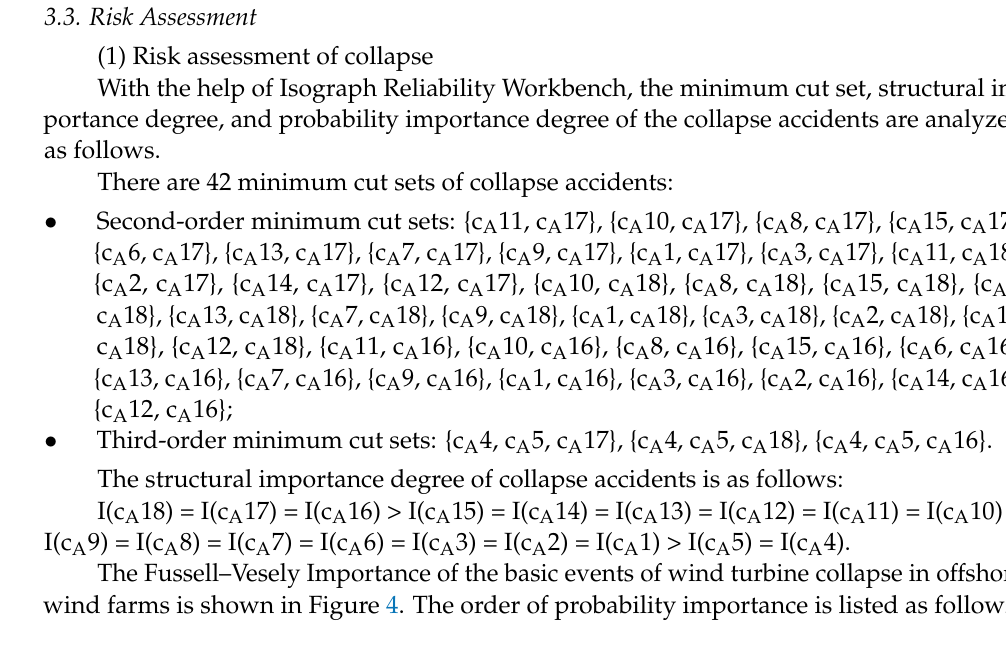
Table 1. Collapse risk factors of offshore wind farms.